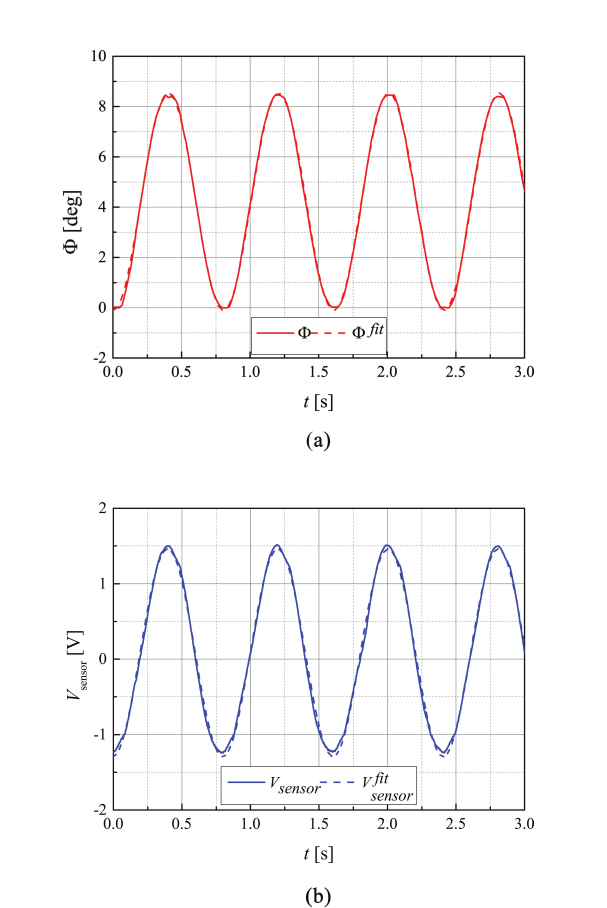
Figure 4. ( a ) Flexural loading applied to the sensor and ( b ) voltage output of the piezoelectric sensor. The red solid lines and dotted lines represent the bending angle and sine-fitted bending angle, respectively. The blue solid lines and dotted lines represent the voltage output and sine-fitted result of the piezoelectric sensor,